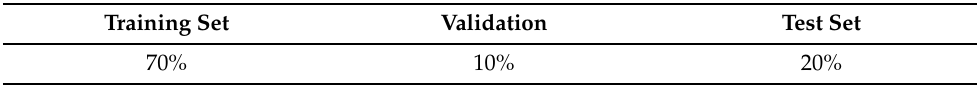
Table 3. Train, validation, and test data